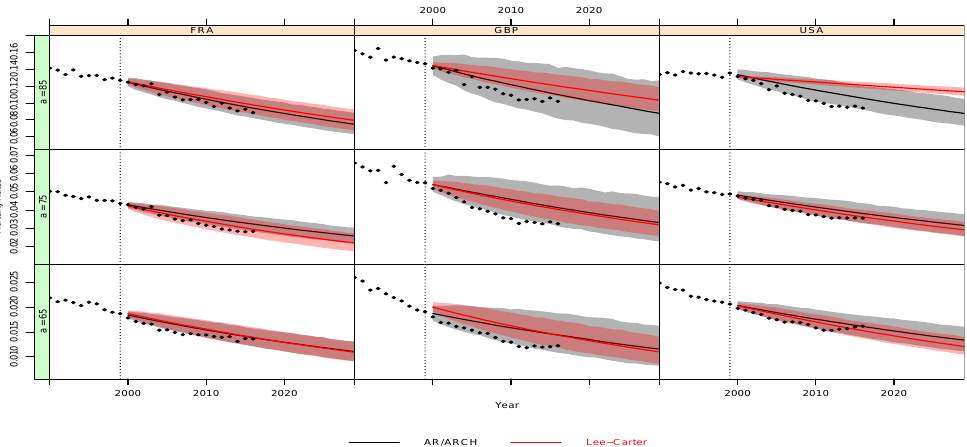
Figure A5. Mortality rates: Forecast mortality rates over the period of 2000–2030 at ages 65, 75, and 85 for the France, England and Wales, and US populations produced by both the selected AR-ARCH (black) model and Lee–Carter (red) model. The 95% prediction intervals are also included. The crude mortality over the observed period is also presented (black